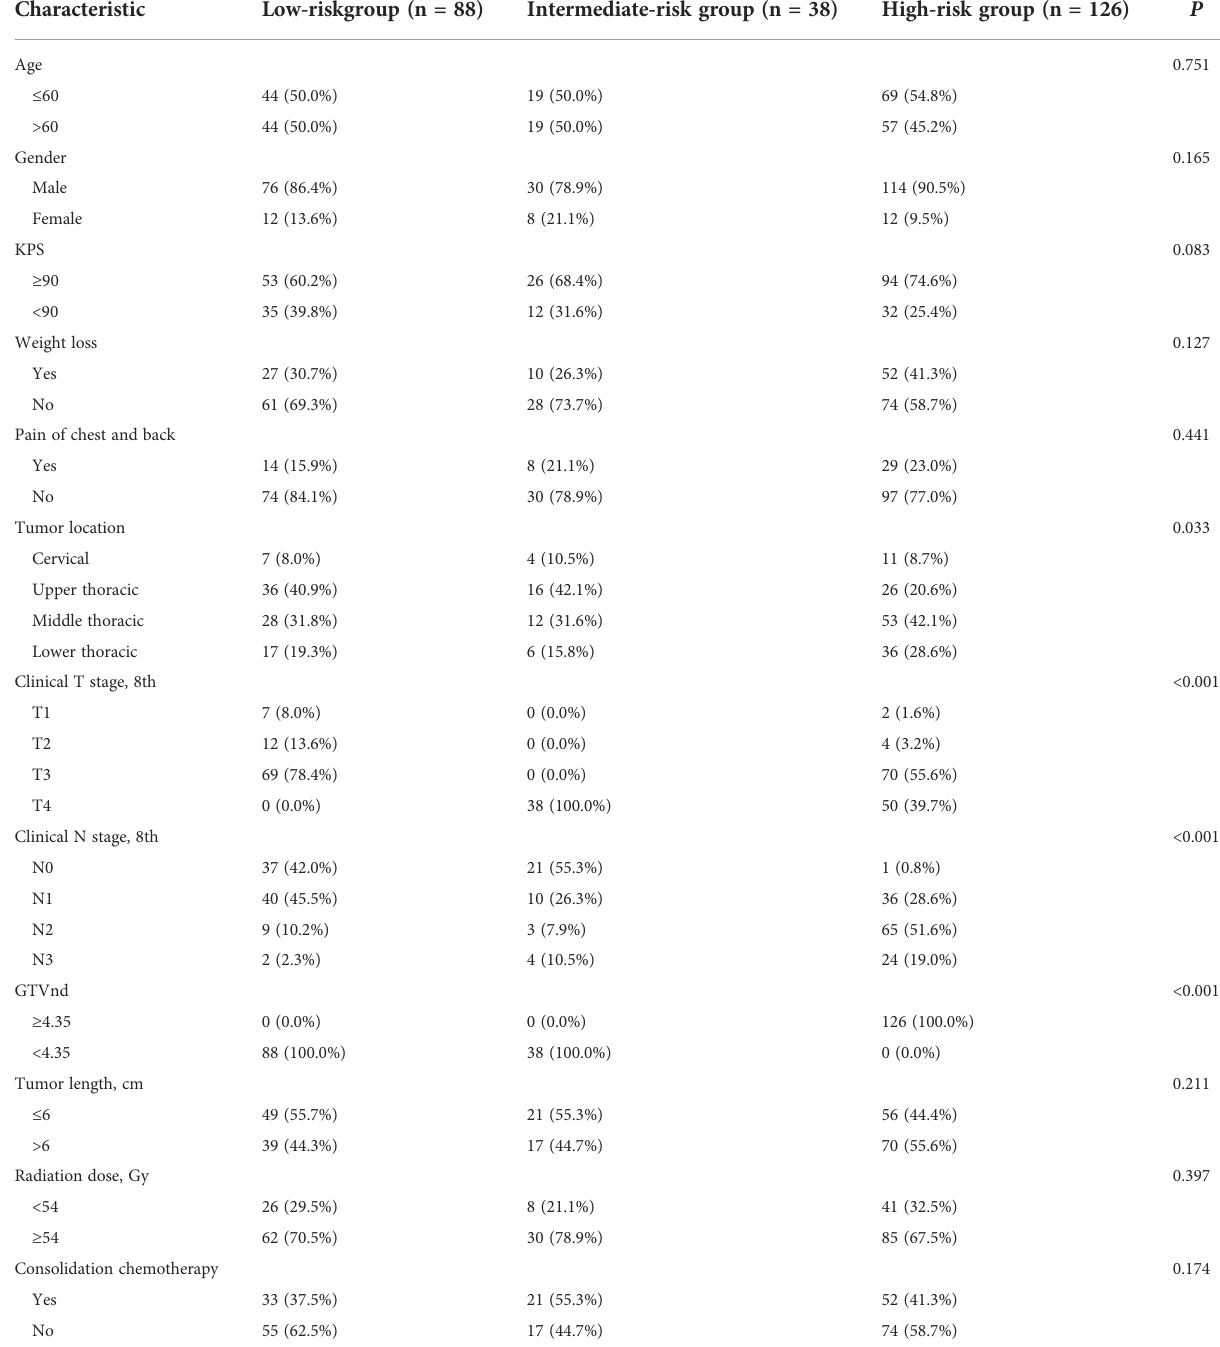
TABLE 4 Baseline characteristics of patients strati fi ed by new risk strati fi